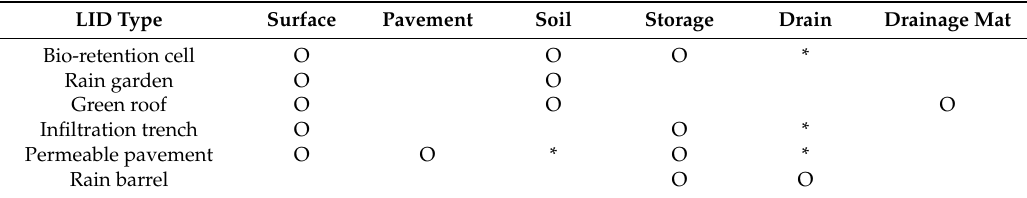
Table 1. Layers used to model different types of low impact development (LID)